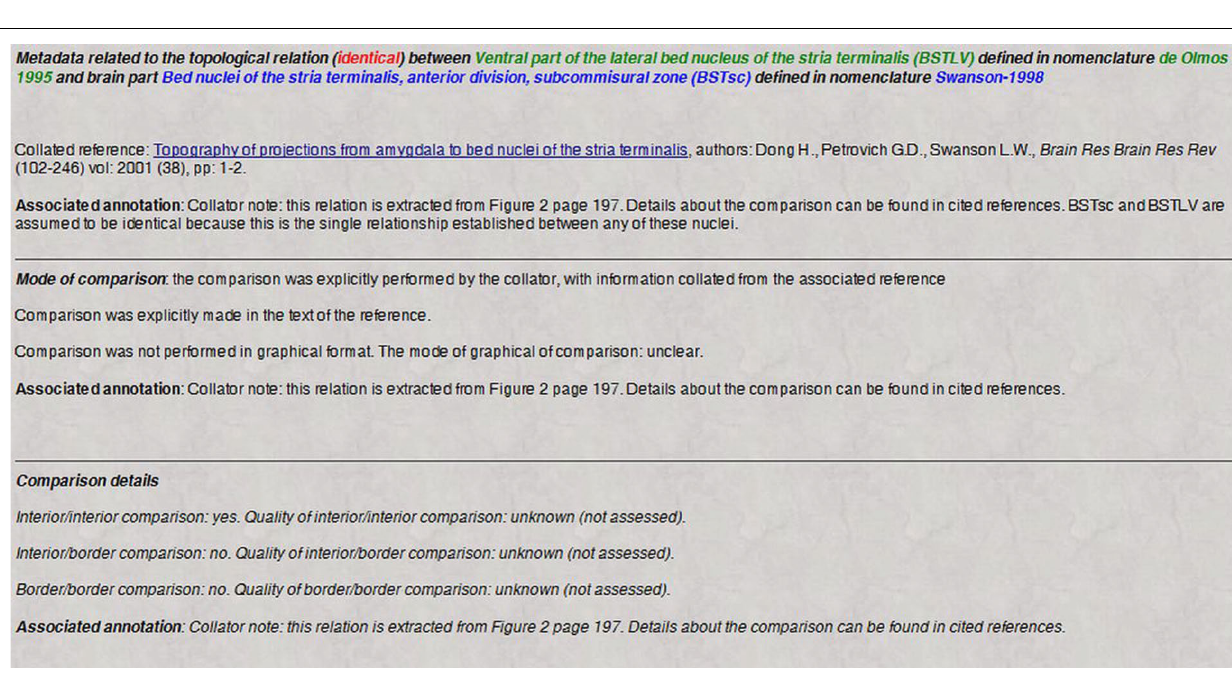
FIGURE 3 | Users can further access details of the comparison process shown in Figure 2, and of the precision of comparison that are collated from the associated reference. See Text for